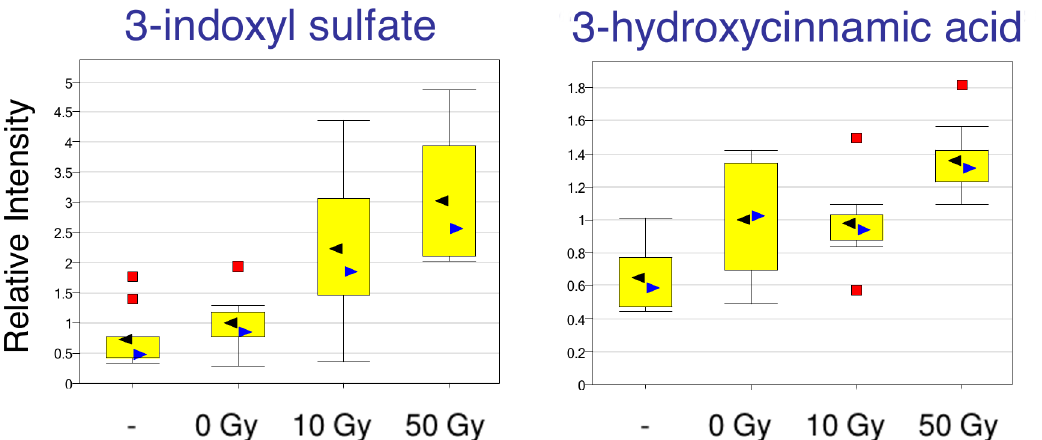
Fig 14. Role of intestinal microbiome in the response to liver Irradiation. Normalized levels of 3-indoxyl-sulfate and 3-hydroxycinnamic acid levels from liver samples are plotted. Radiation dose-dependent increase was observed in these metabolites, indicating possible role of gut microbiome on liver injury. 3-indoxyl-sulfate and 3-hydroxycinnamic acid were both increased in the liver following exposure to radiation. These metabolites are by-products of the intestinal flora, and coupled with those in the Tryptophan pathway point to a possible gut microbiome response to